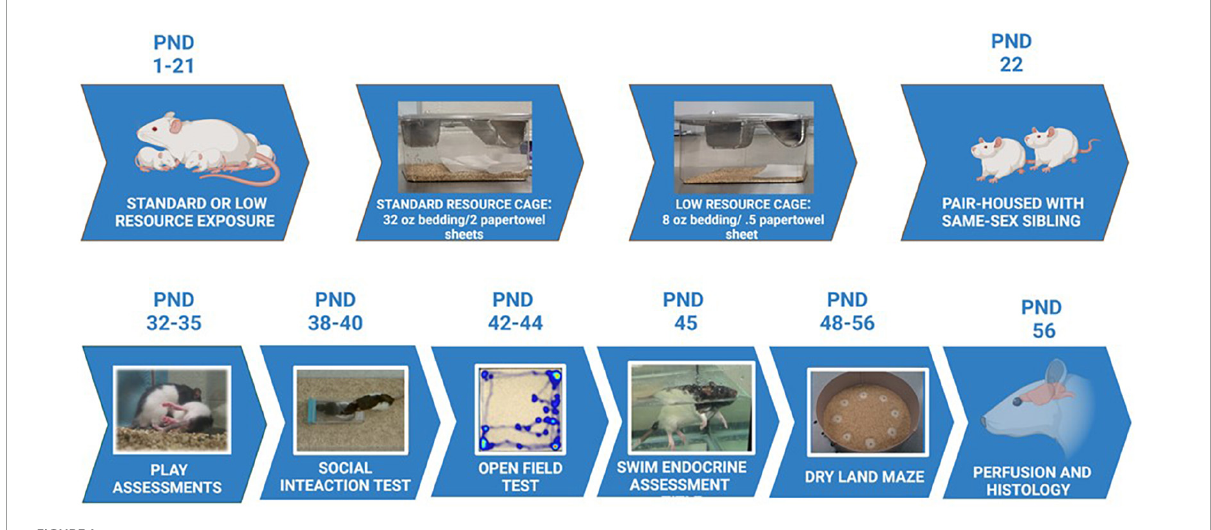
FIGURE1 Experimental timeline. Maternal rats were provided with either standard resources (32 oz. bedding and 2 full sheets of paper towels), or LRs (8 oz. bedding and 1/2 sheet paper towel) from PND 1 to PND 21. Maternal behaviors and pup developmental characteristics were measured during this period. Pups were housed with a same-sex sibling starting at PND 22 in standard housing conditions, and assessed for play behavior, social interaction, exploratory behaviors, stress responses, and learning/memory capabilities during the ages of 4 – 7 weeks. Following all behavioral assessments, animals were perfused and brains assessed for immunohistochemical staining, as well as morphological characteristics in the tendons and vertebrae of the tails.